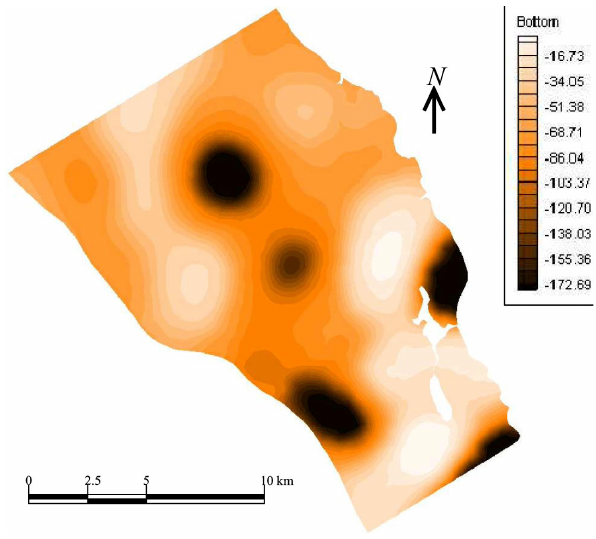
Fig. 13. Interpolation of bottom of well screen. Figure 13: interpolation of bottom of well screen